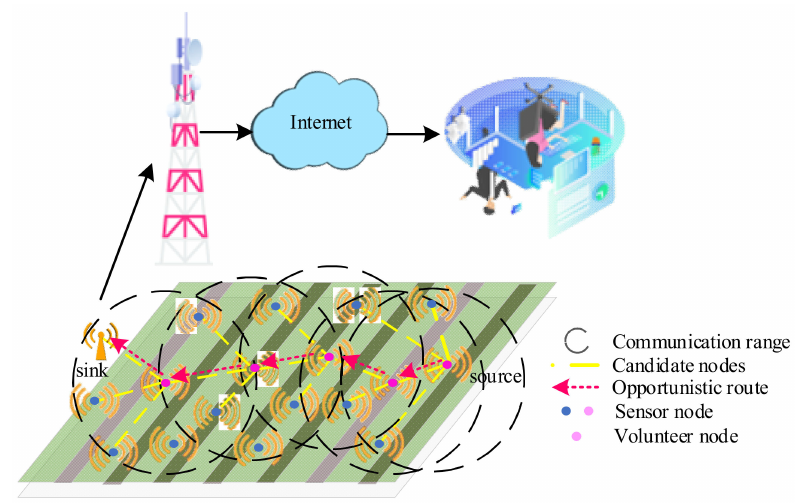
Figure 1. Schematic diagram of opportunistic routing in farm